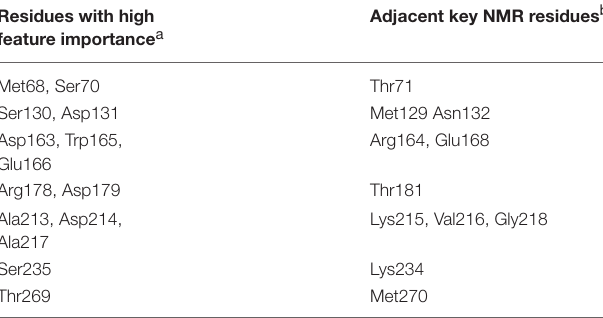
TABLE 1 | The key residues from current study and a NMR